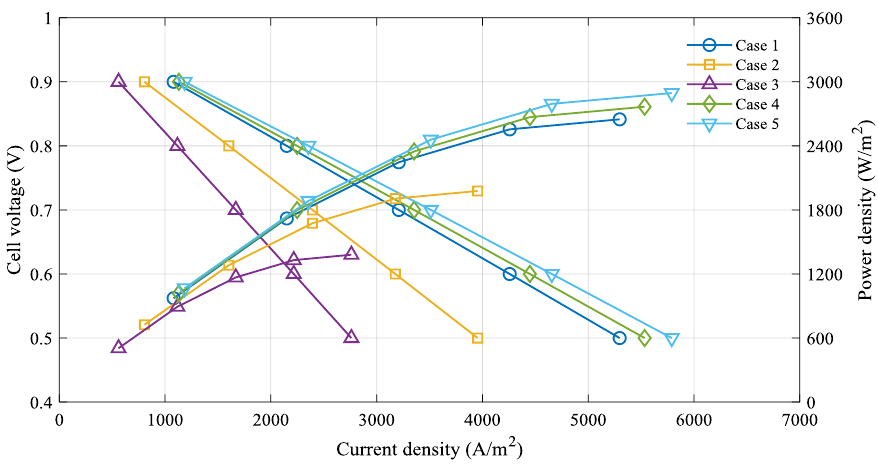
Figure 3. Cell voltage-current-power (V-I-P) curves for all numerical cases.